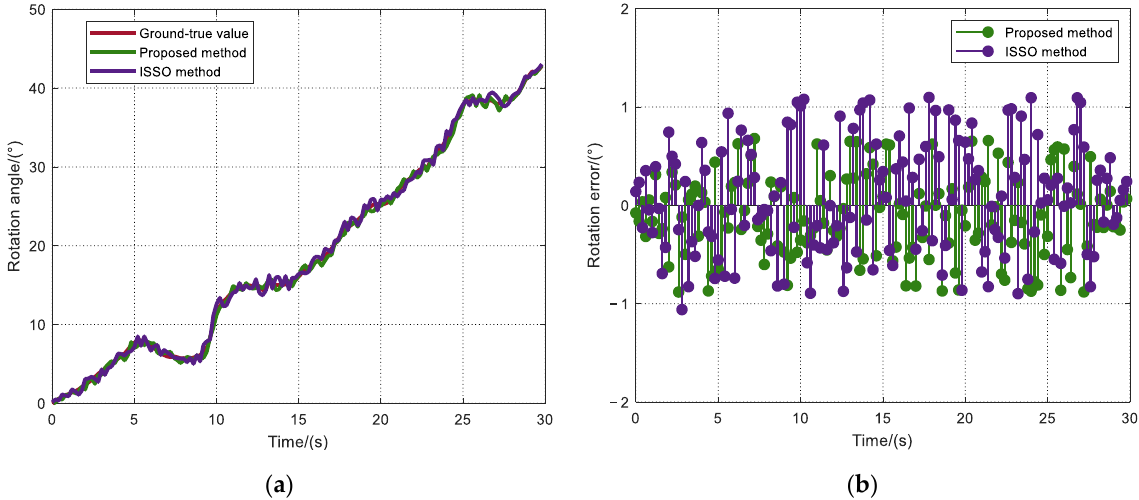
Figure 11. Ground-true value and error of rotation angle. ( a ) The ground-true value of the rotation angle; ( b ) Error of rotation angle.